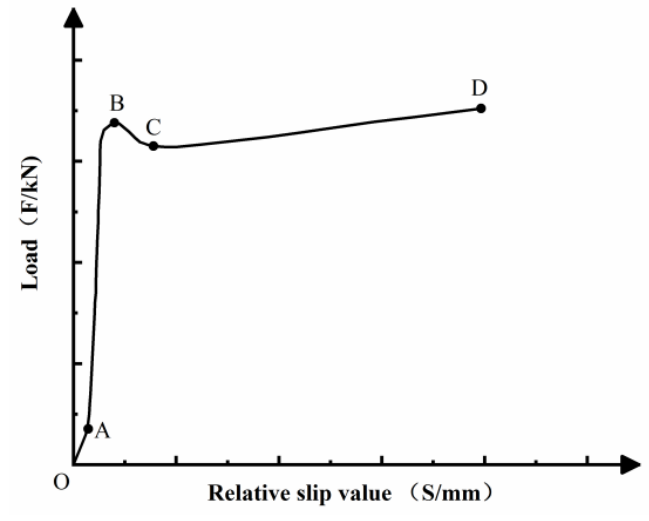
Figure 6. Load-slip curve model of CFST.